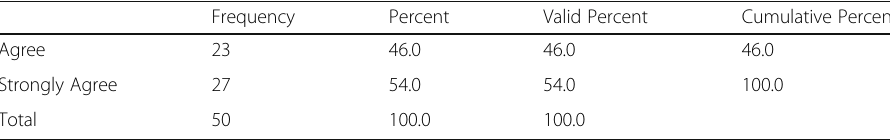
Table 8 Perceived usefulness frequency